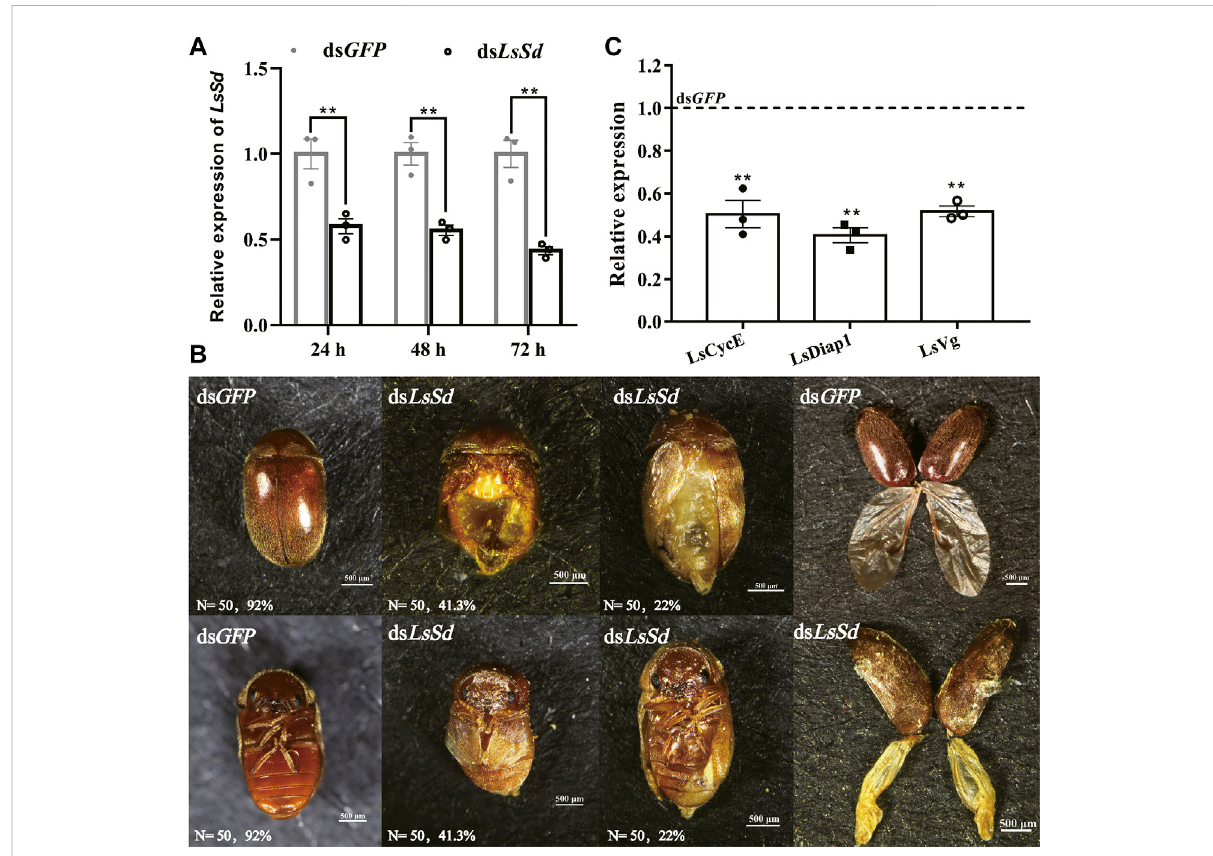
FIGURE 4 The effect of LsSd knockdown on adult phenotypic characterization in L. serricorne . (A) The expression levels of the LsSd gene after RNAi treatment in L. serricorne pupae. (B) Dorsal and ventral views of adults treated with ds LsSd and ds GFP , and structural comparison of wings after LsSd or GFP dsRNAinjection. (C) TheexpressionlevelsofgenesrelatedtocellproliferationandwingwereexaminedbyRT-qPCRafterinjectionofds LsSd in24 h. Error bars indicate theSEM of three independent biological replications. Signi fi cant differences betweencontrol group and RNAigroup were determined by Student ’ s t test. ** p <